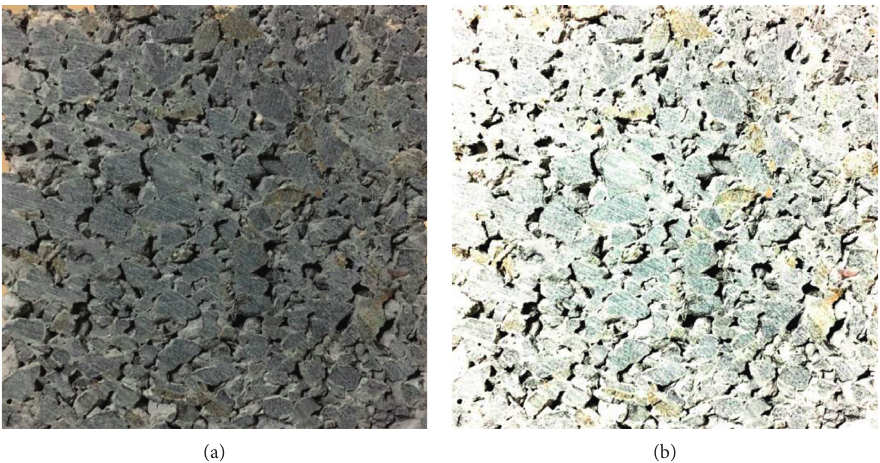
Figure 3: Digital image of cut section: (a) original 2D digital image; (b) enhanced 2D digital image.